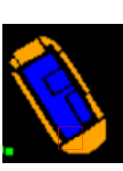
Figure 11. The ground truth of the Grass-synthetic class and the Running-track class in the Houston dataset. The red box represents the region where samples are likely to be ambiguous.